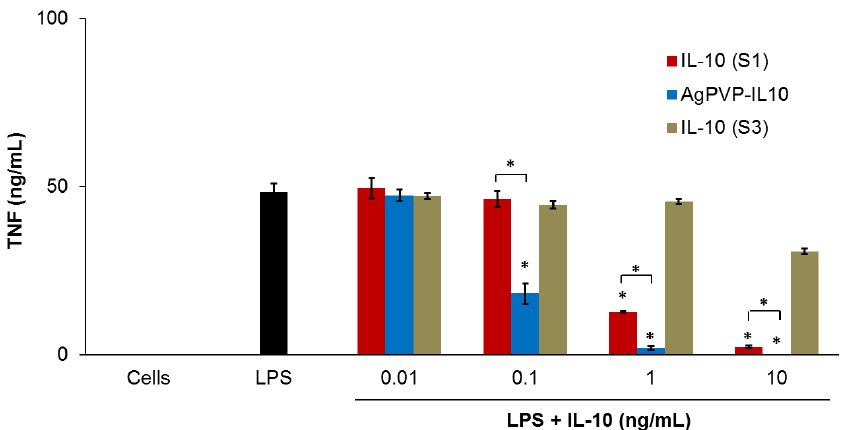
Figure 8. The effect of free rmIL-10 (fresh, S1), rmIL-10 conjugated to Ag-PVPs (stored one week at 4 °C), and free rmIL-10 stored one week at 4 °C (S3) on the production of TNF by mouse J774 macrophages stimulated with LPS. Cells (10 6 cells/mL) were stimulated with 1 μg/mL LPS and treated with different concentrations of either free rmIL-10 or rmIL10-conjugated Ag-PVPs. Cell-free culture supernatants were collected at 72 h post-incubation and titrated by ELISA. Untreated and LPS-stimulated cells were used as positive controls, and untreated and non-stimulated cells were used as negative controls. * indicates a significant difference ( p < 0.01) between the untreated and LPS-stimulated cells versus LPS-stimulated and treated cells as calculated by the unpaired Student’s t -test. The data are presented as means and standard deviations of samples run in triplicate and are representative of three separate experiments.